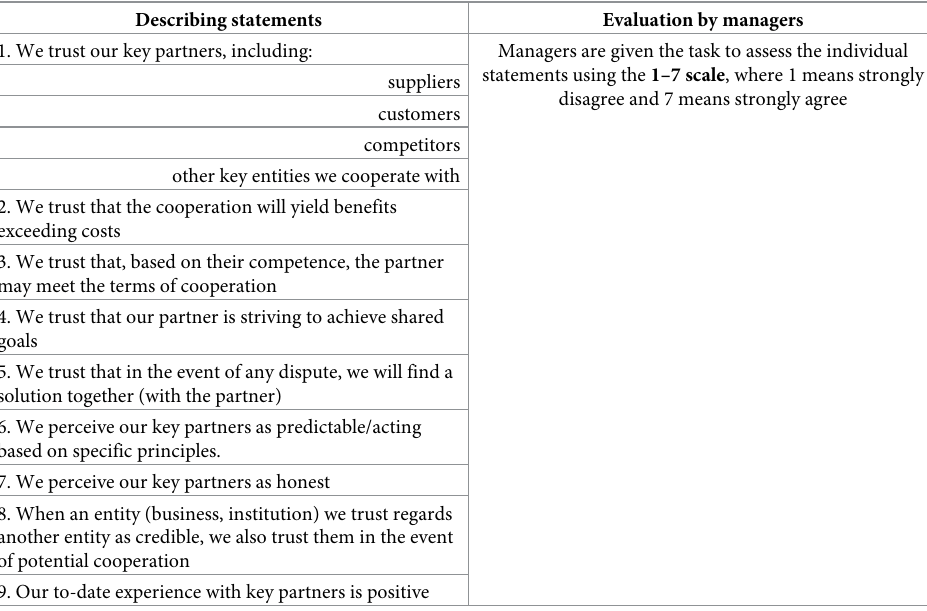
Table 3. Operationalisation of the trust in partners in relation construct—after modification proposed by